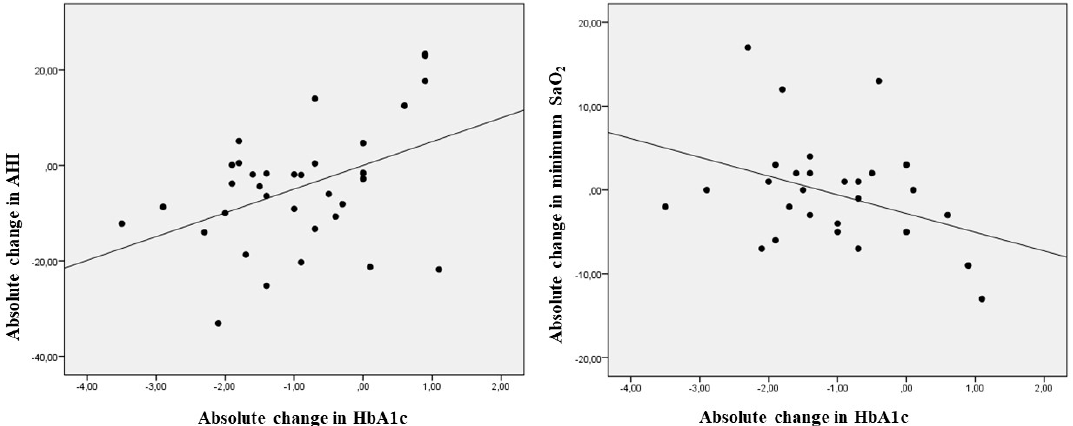
Figure 2. Scatter plot showing the linear correlation between absolute changes in HbA1c and absolute changes in the apnea hypoapnea index and the minimum arterial oxygen saturation during register time. AHI: apnea hypoapnea index; SaO 2 : arterial oxygen saturation; HbA1c; glycated hemoglobin. Finally, the stepwise multivariate regression analysis performed in the entire population with type 2 diabetes showed that baseline AHI together with the absolute change in HbA1c (but not baseline HbA1c, age, gender, known years with type 2 diabetes, smoking status, baseline BMI and absolute change in the BMI) independently predicted changes in the AHI (R 2 = 0.496) (Table 2). In addition, baseline values of HbA1c and AHI independently predicted changes in the minimum SaO 2 (R 2 = 0.288). Table 2. Variables independently related to changes in the apnea–hypopnea index and minimum SaO 2 in the multiple regression analysis (stepwise method).